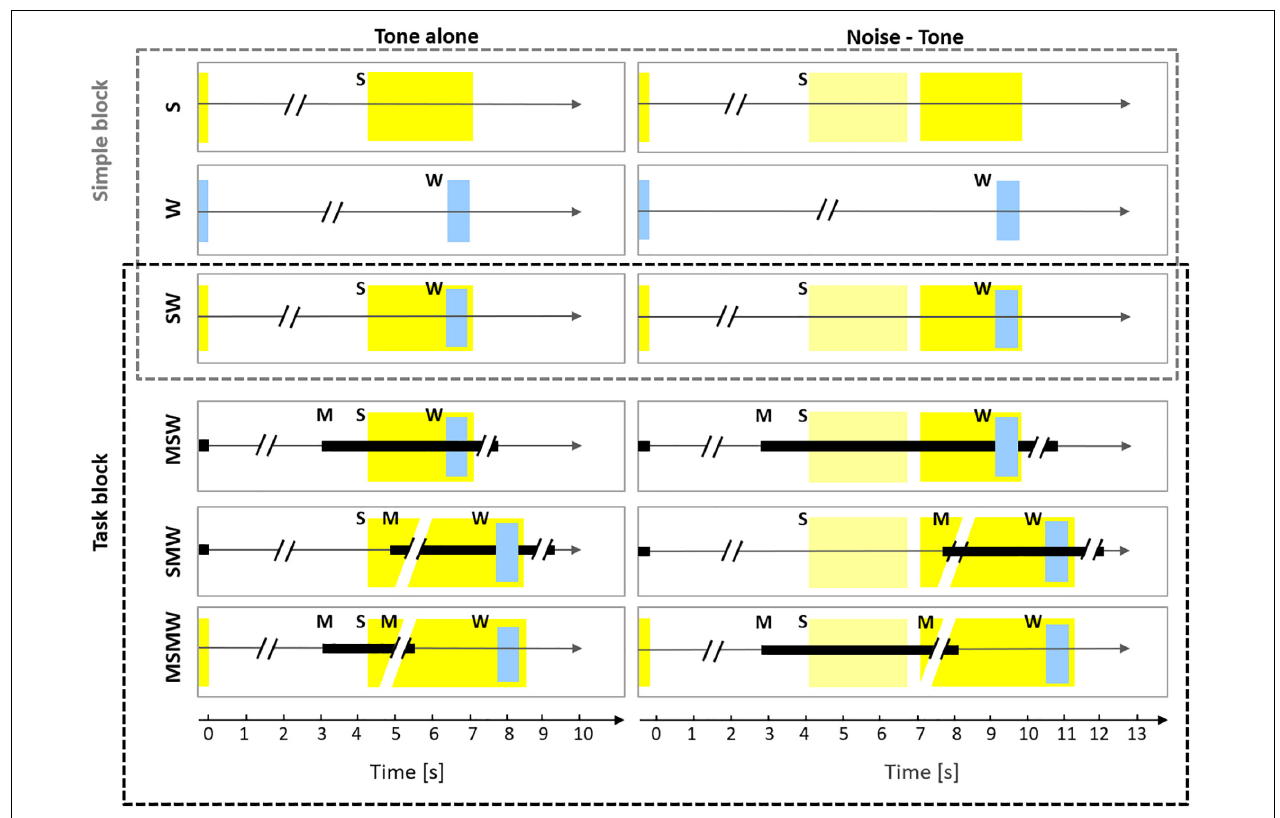
FIGURE 1 | Experimental design. The six rows show the six conditions used in this study which differed in the number and order of the task components S (sound), W (water), and M (motor response). The left column shows conditions in which only a tone was presented (tone alone) and the right column shows conditions in which a noise burst and a tone were presented (noise-tone). The first row depicts the S-condition in which a trial consisted only of sound, either a tone (yellow rectangle; 2.2 s duration) or a noise burst (pale yellow rectangle; 1.6 s duration) followed by the tone. The silent idle period between the sounds presented in consecutive trials varied between 3.5 and 7 s. In the W-condition, only water (W; blue rectangle) was delivered for 0.6 s in a trial and the idle period between consecutive trials varied between 5 and 10.3 s (for the sake of presentation the W-condition is shown in both columns). In the SW-condition, a trial consisted of sounds and water, the latter was delivered from 1.5 to 2.1 s after tone onset. The SW-condition was tested both in the Simple block (upper three conditions) and in the Task block (lower three conditions). In the MSW-condition, the monkeys themselves initiated a trial by bar touch. While holding the bar (black rectangle), sounds were presented and water was delivered. In the SMW-condition, a trial was externally initiated by a computer and started with sounds, in response to which the monkeys had to touch the bar at the earliest 0.3 but not later than 1.2 s after the onset of the tone. After holding the bar for 1.5 s, water was delivered. The monkeys had to release the bar and remain idle for 3.5–7 s before the next trial. In the MSMW-condition, the monkeys initiated a trial by bar touch. While holding the bar, sounds were presented. The monkeys had to release the bar from 0.3 to 1.2 s after the onset of the tone, which was rewarded with water 1.5 s after